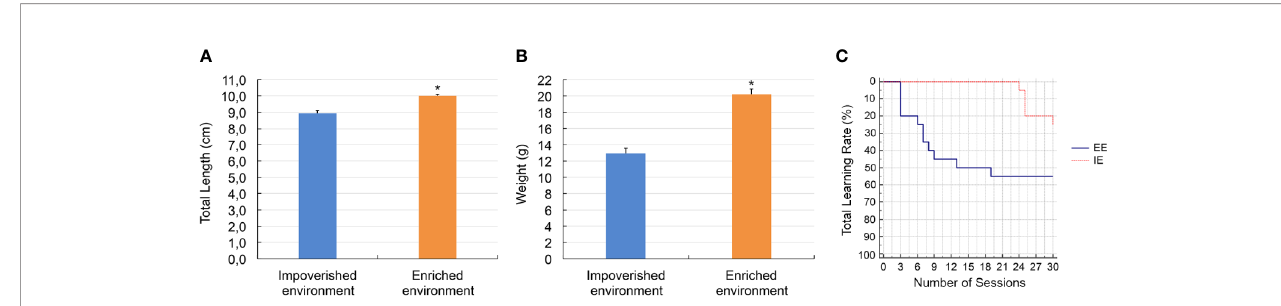
FIGURE 5 | Length (A) , body weight (B) , and learning rates (C) , with signi fi cantly greater mean values for juvenile fi sh growing in the enriched aquaria. (*) indicates statistically signi fi cant differences. Kaplan-Meier curves (C) (log-rank test with a Chi-squared value of 58.6, degrees of freedom = 1, p = 0.01), showing statistically signi fi cant differences between the EE and IE learning